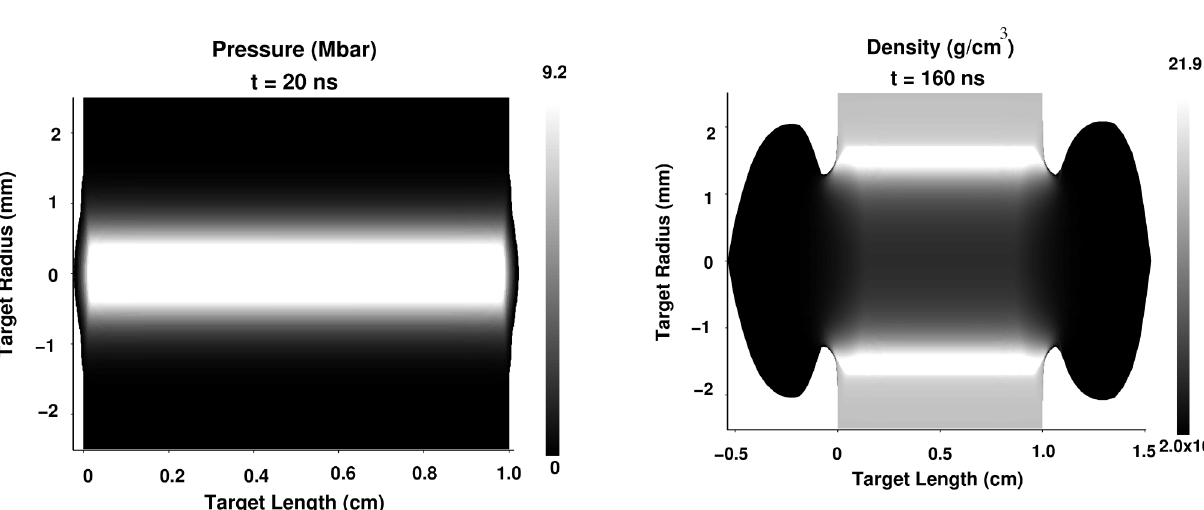
FIG. 8. Density at t (cid:3) 160 ns corresponding to the case shown in Fig. 5.